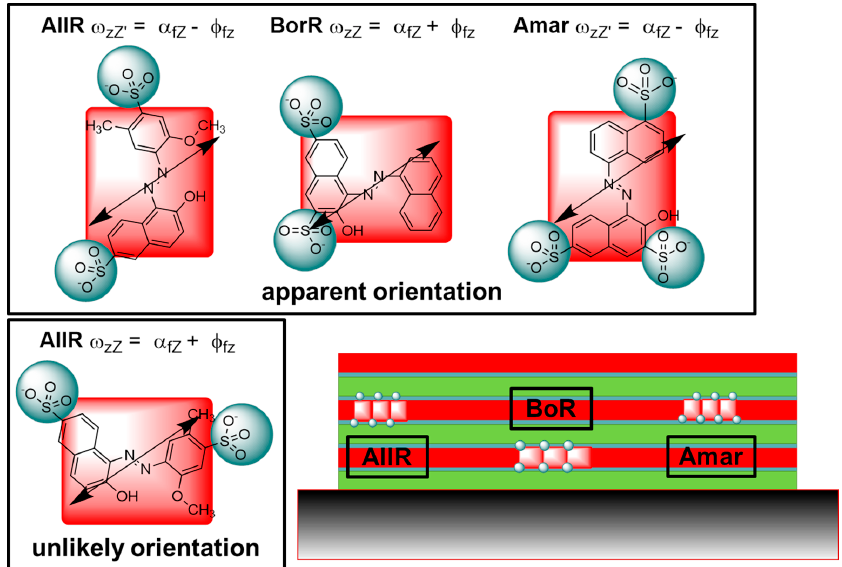
Figure 7. Molecular structure in thin films of the ionic self-assembled materials as determined by polarized absorption spectroscopy illustrated on a model of the lamellar structure with dye layers (red), ionic interface layers (gray), and layers of alkyl chains (green). The method is not able to differentiate between the two orientations shown for Allura Red AllR , but considerations on the lamella structure suggest that the orientation which positions the two charged groups at either side of the molecule would be preferred. The preferred orientation of Bordeaux Red BorR and Amaranth Amar is